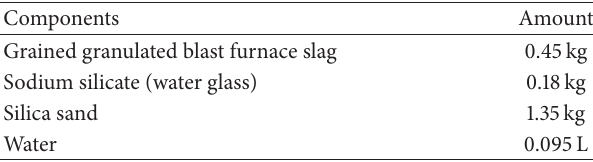
Table 1: The mixture composition.